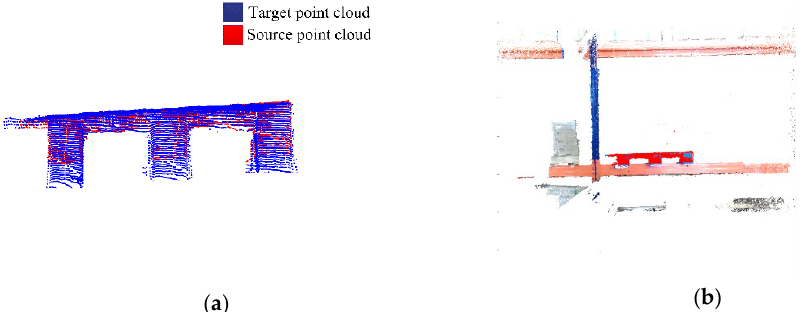
Figure 19. Visualization of pallet pose estimation results. ( a ) Registration result ( b ) Pallet pose estimation.